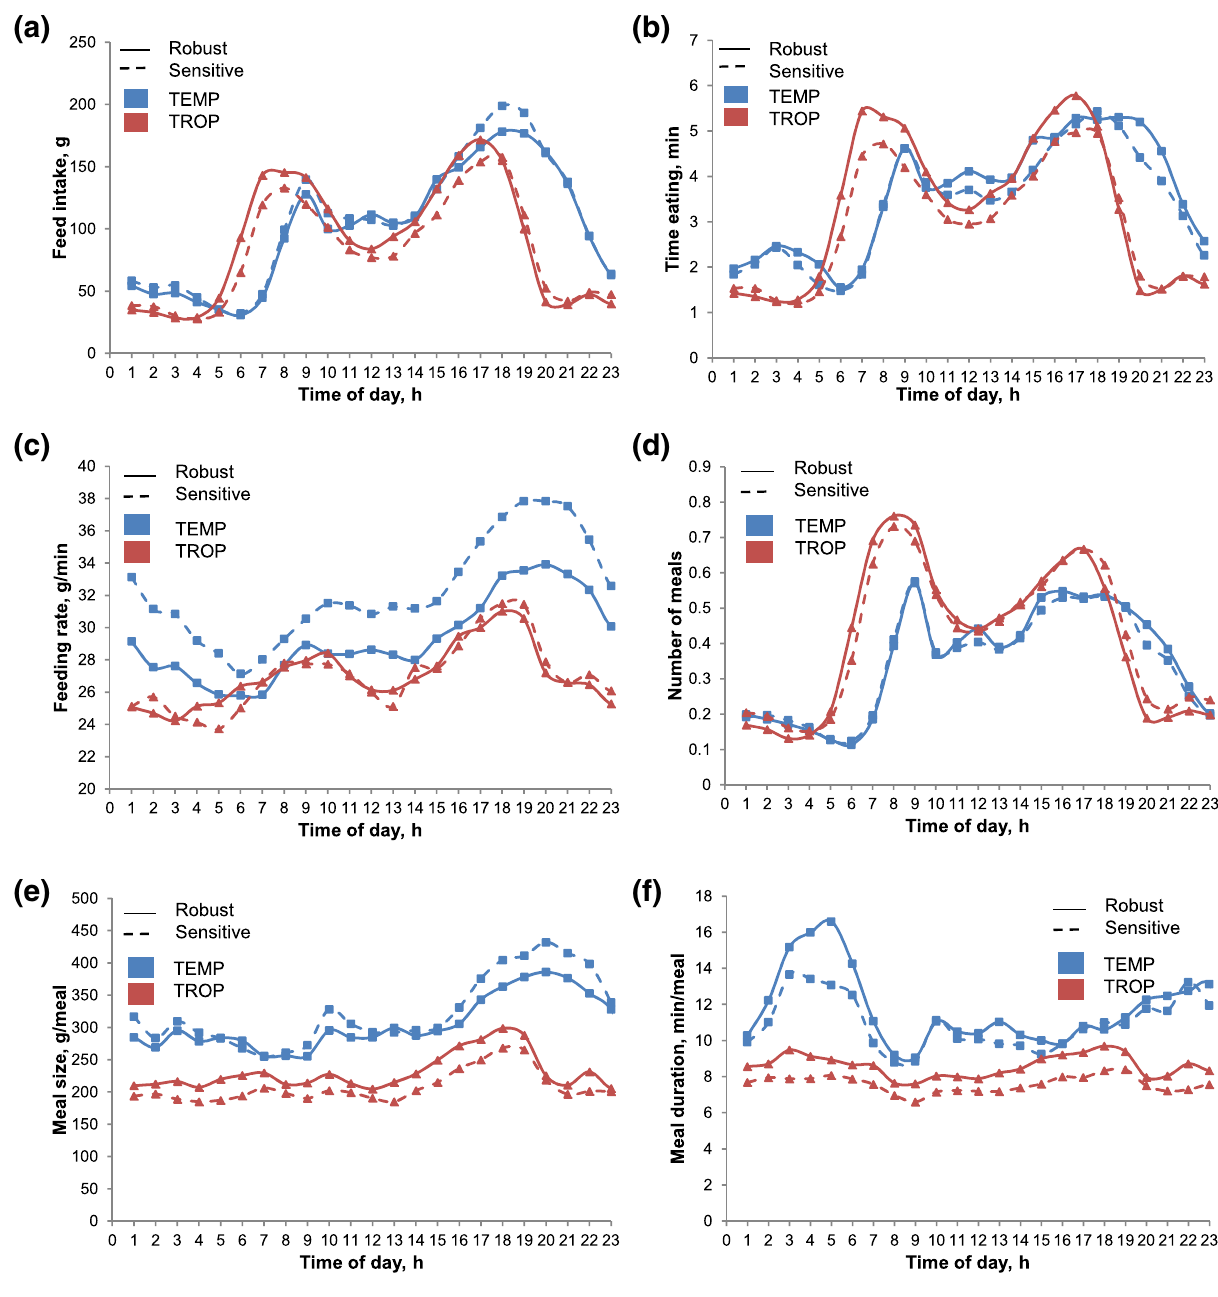
Figure 4. Hourly distribution of feeding parameters according to the robust/sensitive group: robust group (solid line), sensitive (dotted line) and production environment: temperate (red), tropical (blue). ( a ) Feed intake, ( b ) time feeding, ( c ) feeding rate, ( d ) number of meals, ( e ) feed intake per meal, ( f ) time per meal. In TEMP conditions: robust group, n = 179; sensitive group, n = 194. In TROP conditions: robust group, n = 216; sensitive group, n =